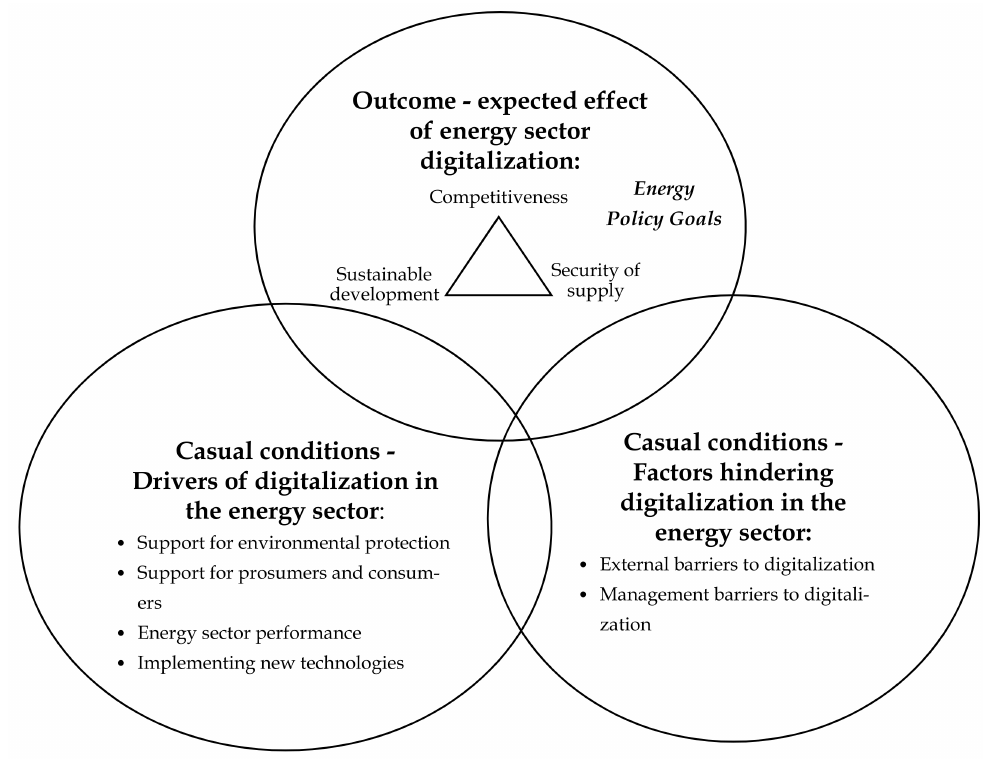
Figure 3. Conceptual framework—drivers and barriers of digitalization in the energy sector. Source: own